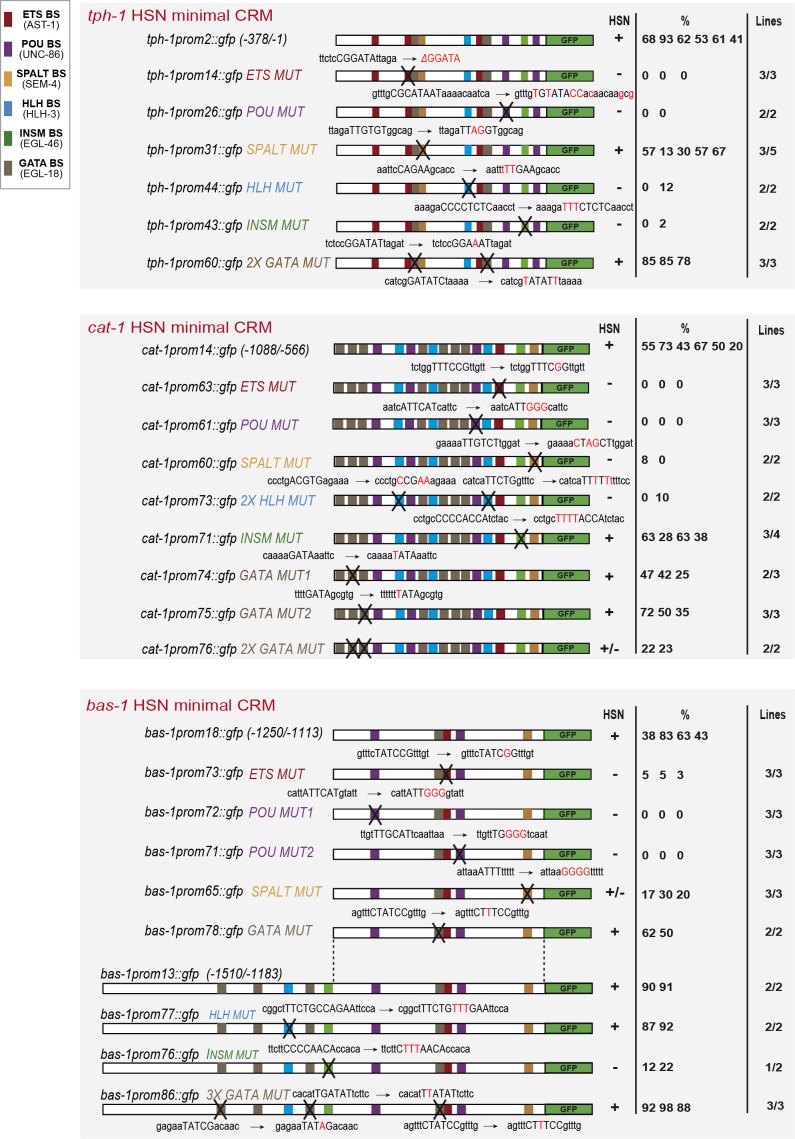
Primary data from the mutagenesis analysis (Figure 5).Each number represents the % of GFP cells in a particular transgenic line. +: > 60% of mean wild type construct expression, +/−: values indicate a penetrance of 20–60% the mean wild type expression value; −: values are less than 20% of mean wild type values. n > 60 cells per line. Above each construct, the wild type consensus sequences are included in capital letters in a longer region context and after the arrow the point mutations are highlighted in red. Related to Figure 5.